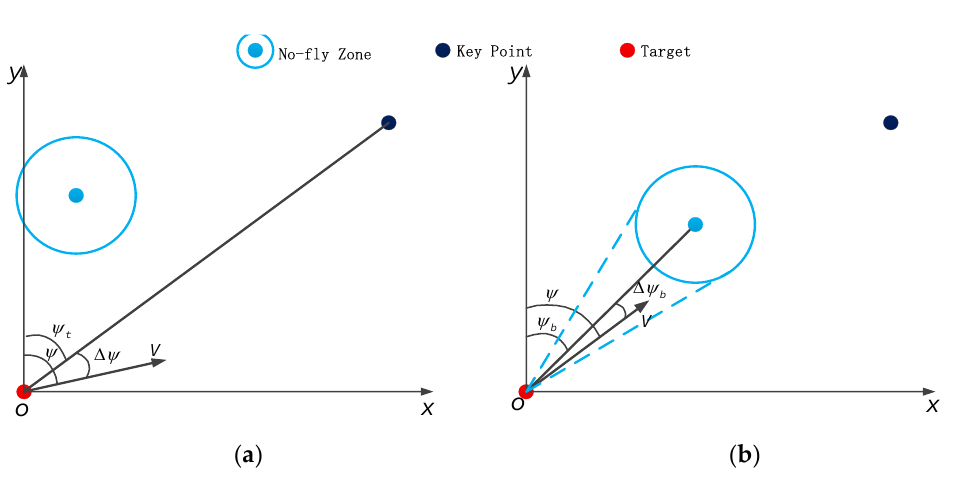
Figure 10. Sign variation rule of bank angle: (a) is the case the no-fly zone has no influence on the target; (b) is the case the no-fly zone has influence on the target.